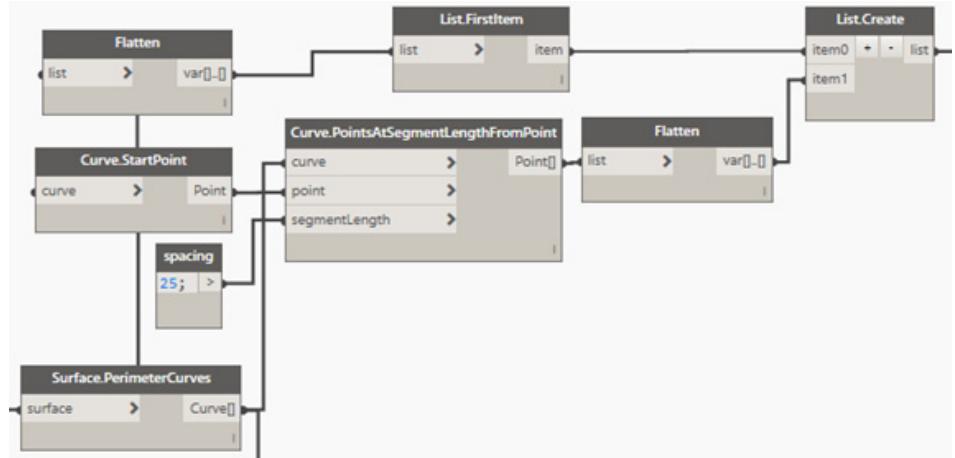
Figure A7. Creation of the points cloud that defines the printing trajectory.